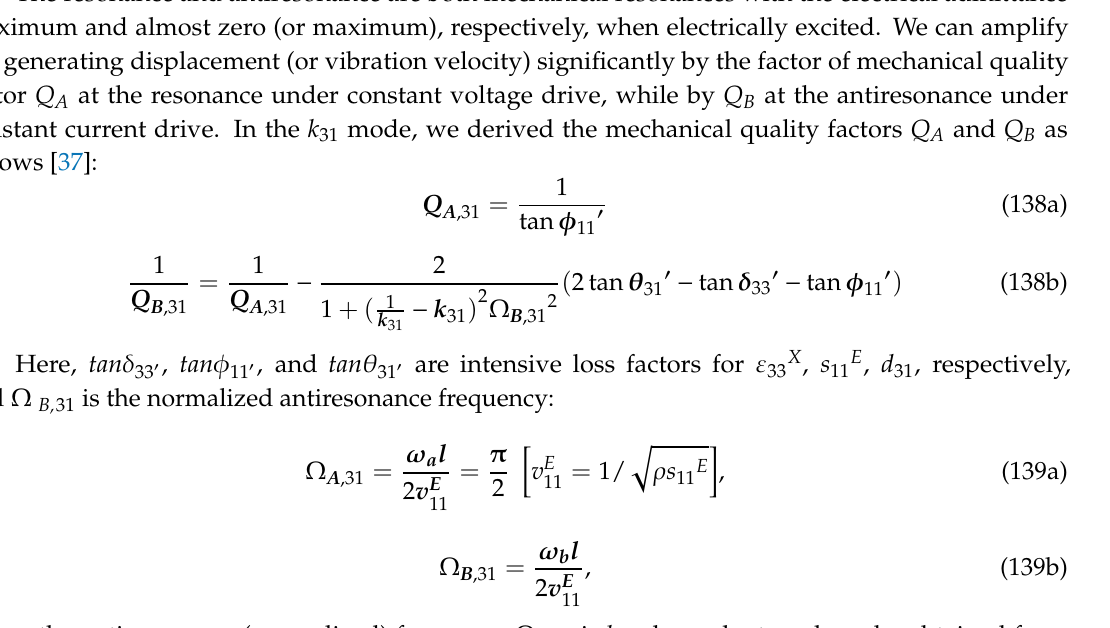
Figure 17. Temperature variations in a PZT-based plate sample observed with an infrared camera, driven at: ( a ) first resonance and ( b ) second resonance mode.